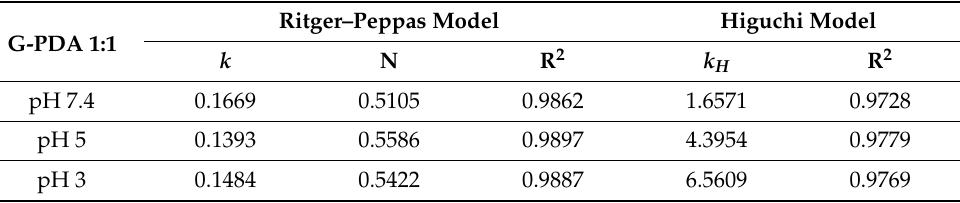
Table 2. Parameters for release kinetics obtained after fitting of Plots in Ritger − Peppas and Higuchi Models.